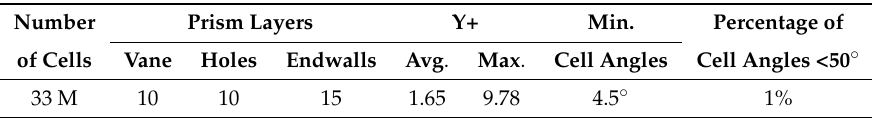
Table 2. Mesh Quality